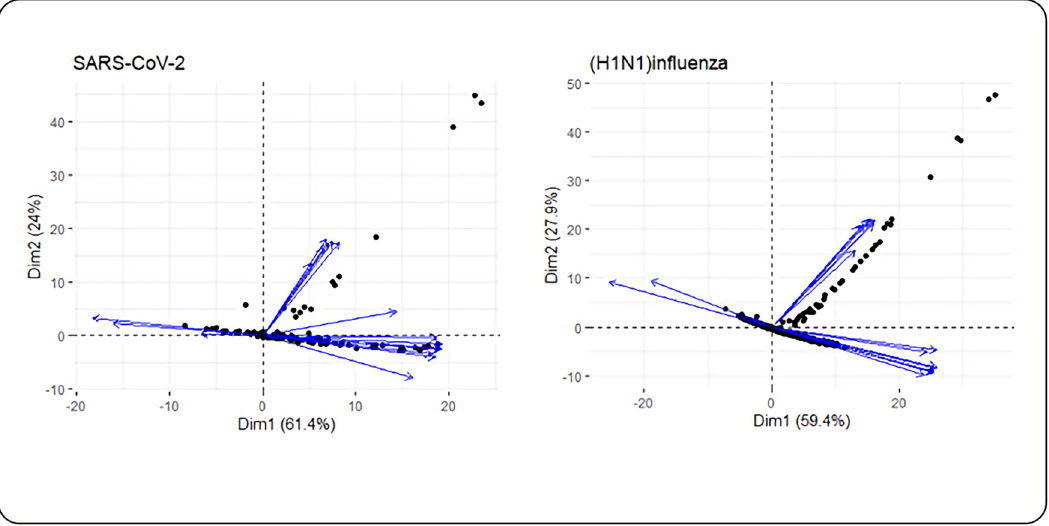
Figure 5. Biplot representation of the centrality measures in SARS-CoV-2 and (H1N1) influenza PPINs. In each plot, nodes were shown as points and centrality measures as